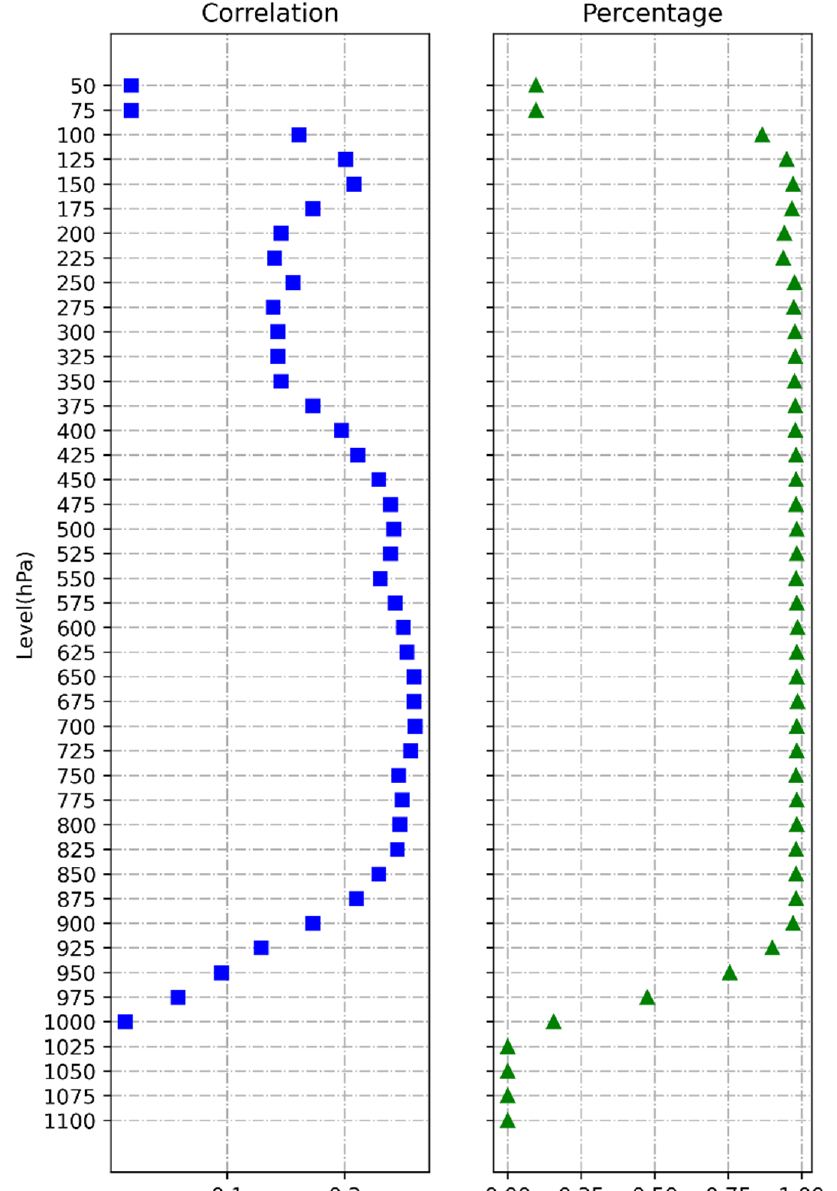
Figure 6. Correlation coefficients and proportions of AWS passing significance tests for surface precipitation and cloudiness at various levels in Hainan Province, from June to August 2021.